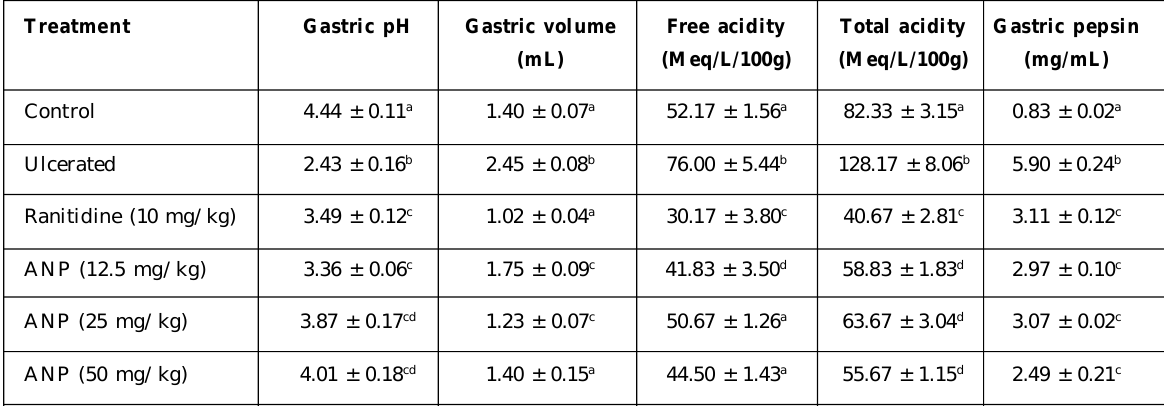
Table 2a: Gastric acid secretory indices in indomethacin - Induced ulcerated rats treated with A. nilotica seedpod aqueous extract